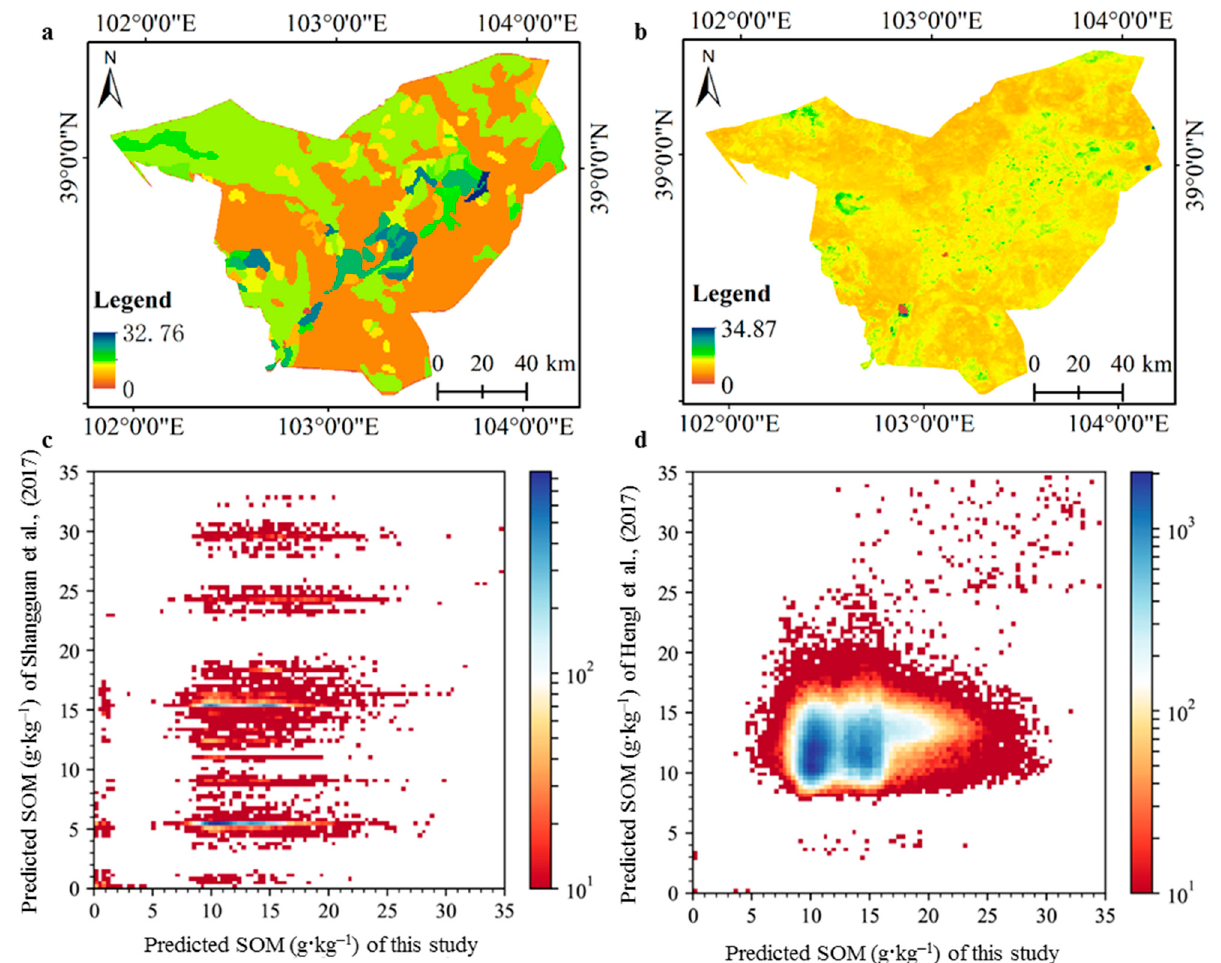
Figure 9. Comparisons with existing datasets. ( a ) the 30 × 30 arc-second resolution gridded SOM dataset developed by [20]. ( b ) the SOM maps improved from SoilGrids SOC dataset at 250-m resolution, developed by [21]. Both datasets reflect soil properties within 30 cm depth. ( c , d ) 2D histogram plots for predicted SOM of RF with 30 × 30 arc-second resolution gridded SOM dataset ( c ) and SoilGrids SOM ( d ) with bin size of 0.35 for both axes. Total pixels in each bin were calculated and then normalized by logarithmic function for clear